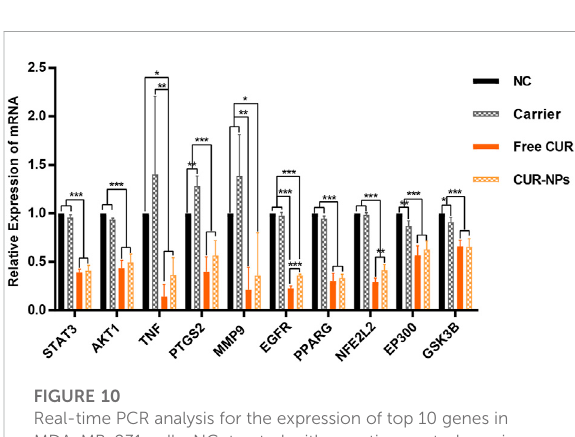
FIGURE 10 Real-time PCR analysis for the expression of top 10 genes in MDA-MB-231 cells. NC, treated with negative control; carrier, treated with the carrier of PEG 5k -b-PLLA 5k ; CUR, treated with free CUR; CUR-NPs, treated with CUR-loaded PEG 5k -b-PLLA 5k nanoparticles. * p < 0.05, ** p < 0.01, *** p <